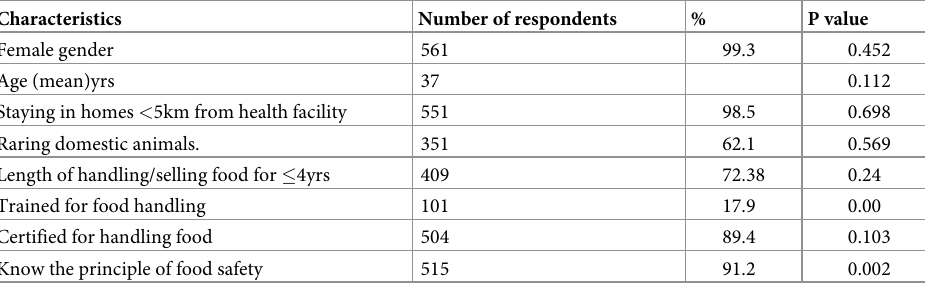
Table 1. Demographic characteristics of the study food handlers in West Coast Region. Characteristics